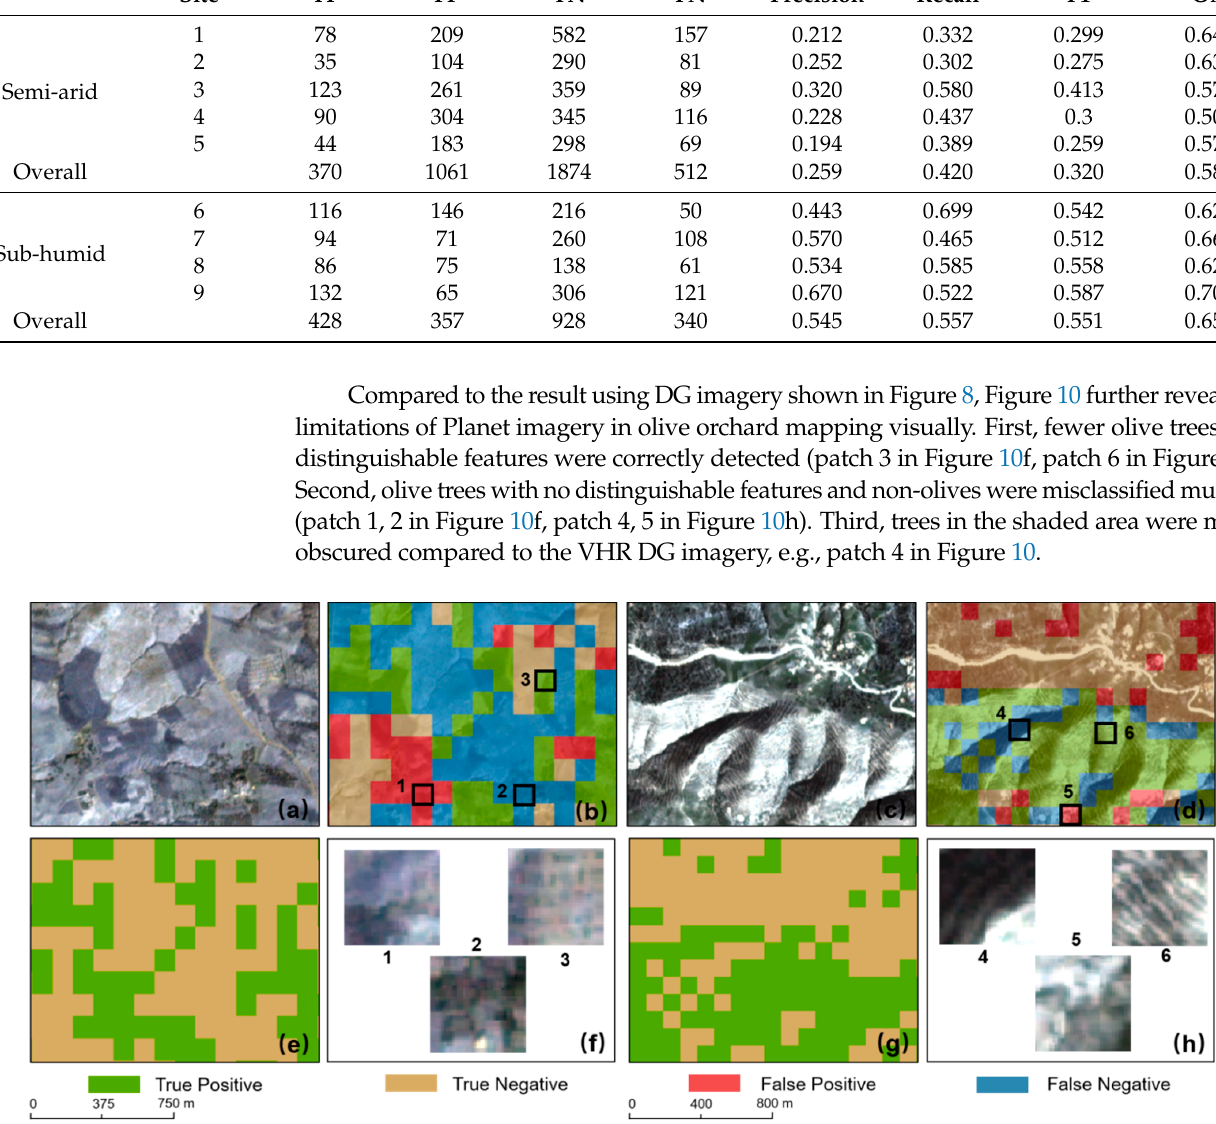
Table 7. Evaluation metrics of olive mapping using single time Planet imagery using CNN.